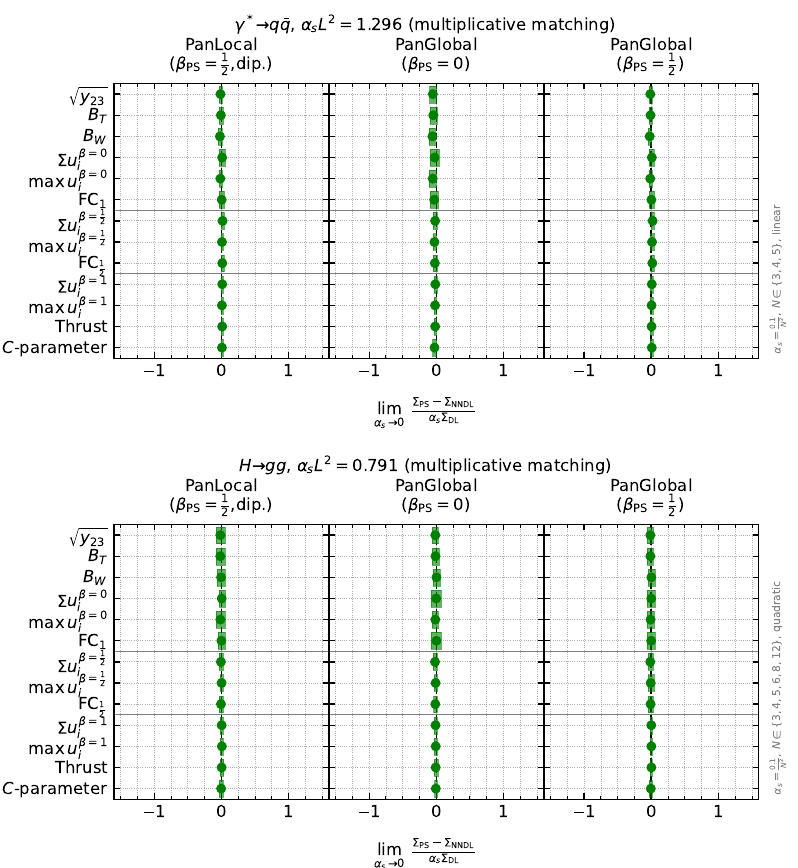
) and PanGlobal 2